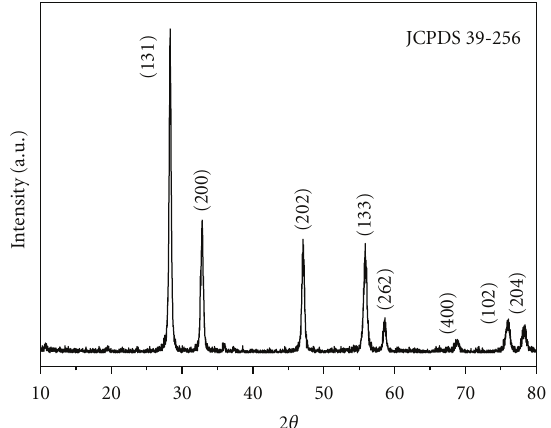
Figure 1: The XRD pattern of Bi 2 WO 6 sample prepared by hydro- thermal method.